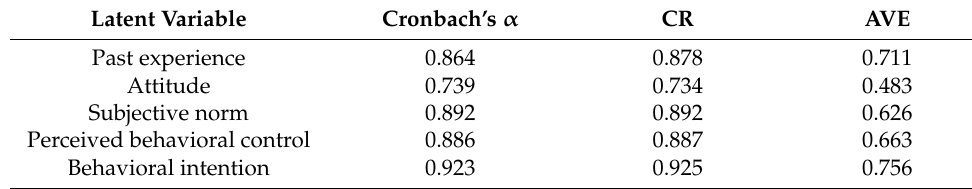
Table 3. Reliability and validity test.